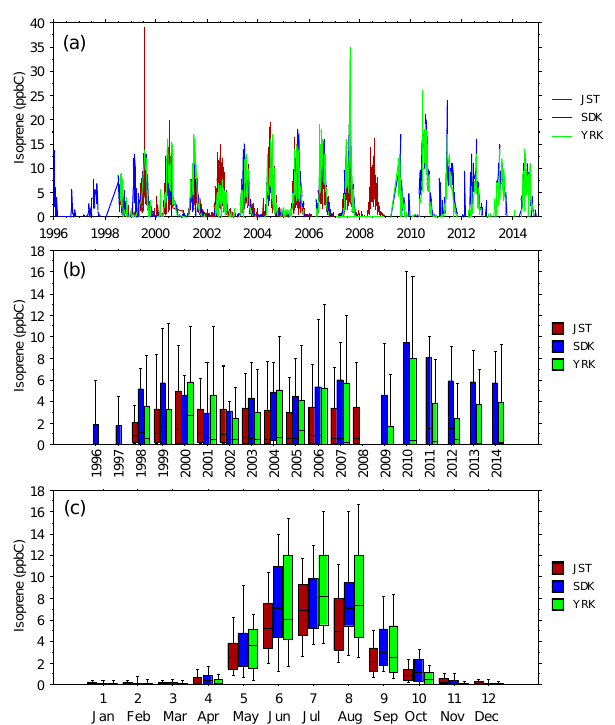
Figure 6. (a) Daily-average isoprene mixing ratios vs. date, (b) sta- tistical distributions of daily-average isoprene mixing ratios vs. year, and (c) statistical distributions of daily-average isoprene mix- ing ratios vs. month. Samples were obtained every day at JST and once every 6 days at YRK and SDK (Blanchard et al., 2010a). Dis- tributions indicate the 10th, 25th, 50th, 75th, and 90th